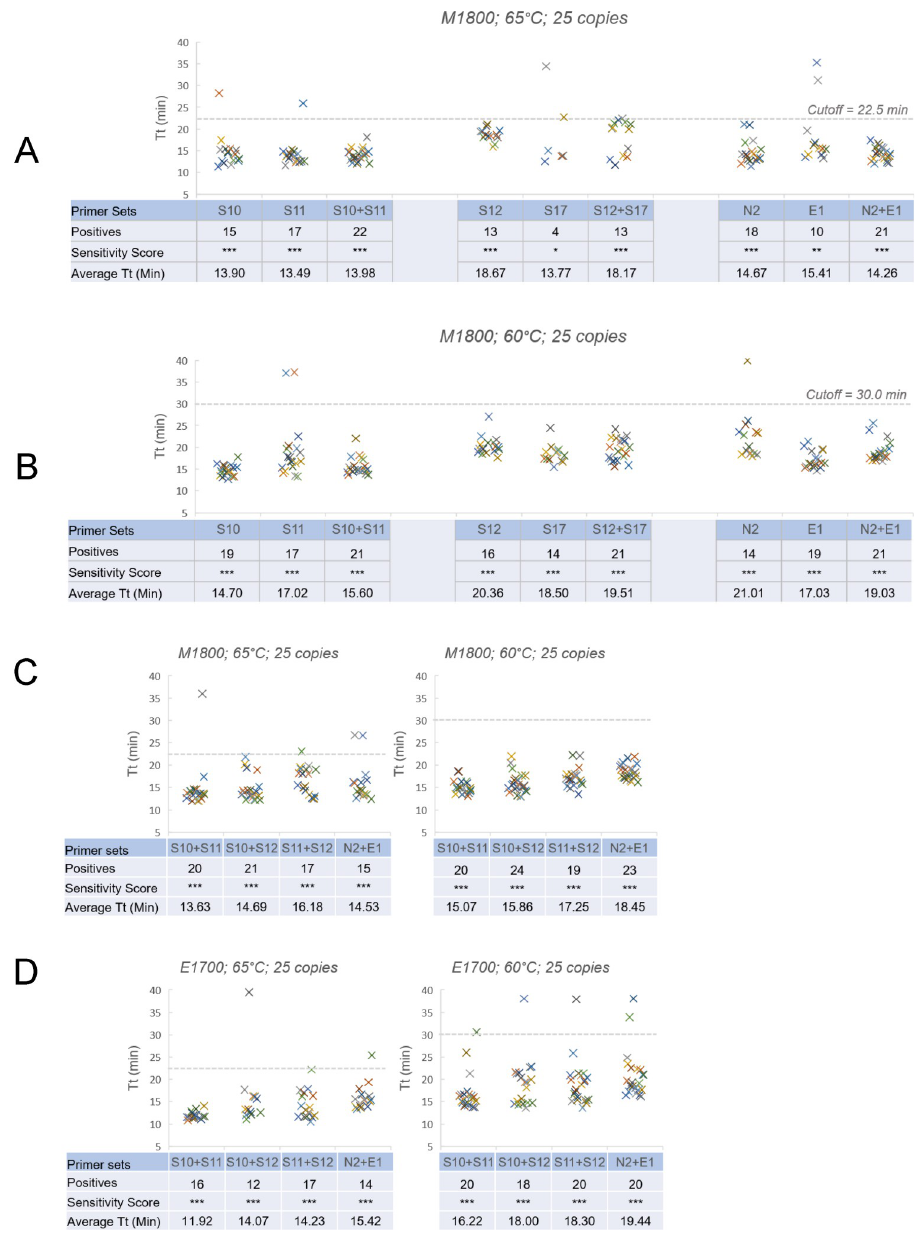
Fig 2. Increased detection sensitivity by combining 2 primer sets. Reactions were performed with single primer sets and various combinations of 2 primer sets in the presence of 25 copies of SARS-CoV-2 RNA template per reaction. The sensitivity score was adjusted as: sensitive ( ��� 12–24 positives); medium ( �� 6–11 positives) or poor ( � 1–5 positives). (A) Reactions with single primer sets were compared to combinations of 2 sets using M1800 at 65˚C. (B) With M1800 at 60˚C. (C) Comparing reactions with 4 different dual primer set combinations (S10+S11, S10+S12, S11 +S12 and N2+E1) in M1800 at 65 and 60˚C. (D) The same dual primer sets in E1700 at 65 and 60˚C.